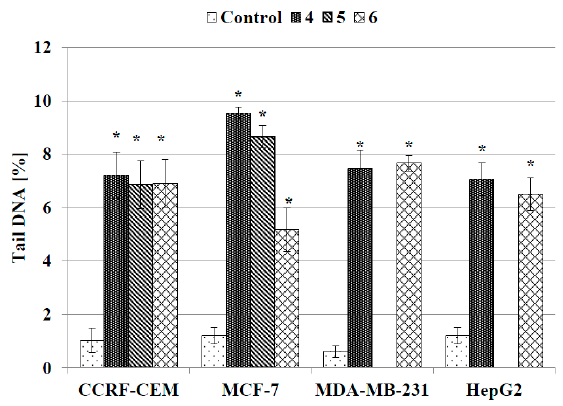
Figure 7. DNA content in the tail of the comet obtained from human cancer cells